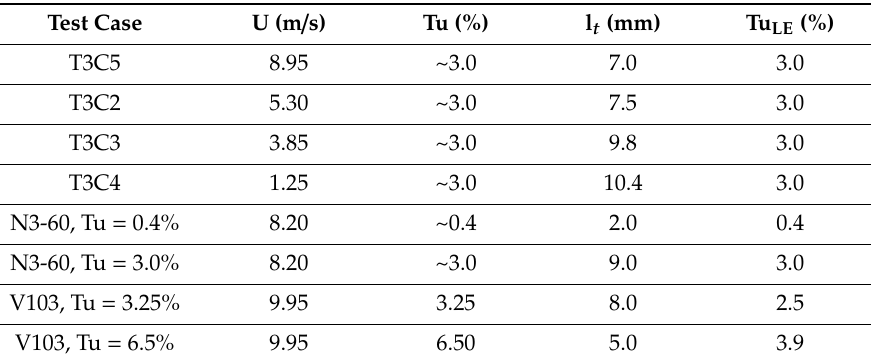
Table 3. Boundary conditions at the inlet of the computational domain and free-stream turbulence intensity in the leading edge plane for the ERCOFTAC flat plates, the N3-60 and V103 cascades. U denotes the velocity normal to the inlet